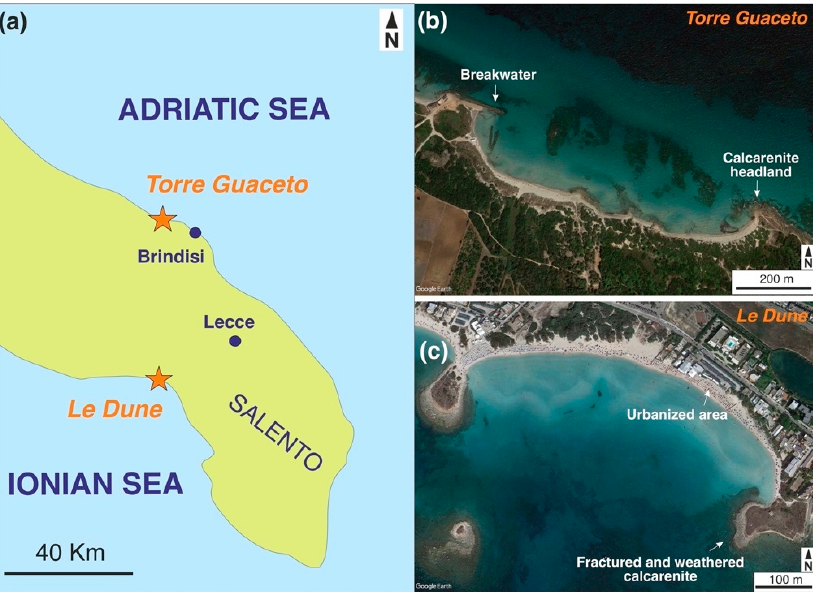
Figure 2. Coastal features of Torre Guaceto and Le Dune beach. ( a ) Geographical location of the study areas (orange star); ( b ) satellite image of Torre Guaceto beach showing a landward well developed dune belt; ( c ) satellite image of Le Dune beach showing a large, urbanized area on the southernmost sector and a developed dune environment on the northwestern